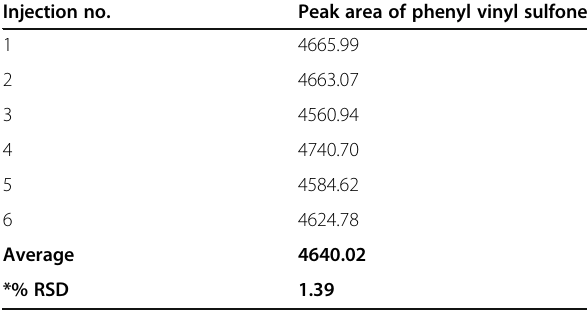
Table 2 System suitability results of phenyl vinyl sulfone Injection no.